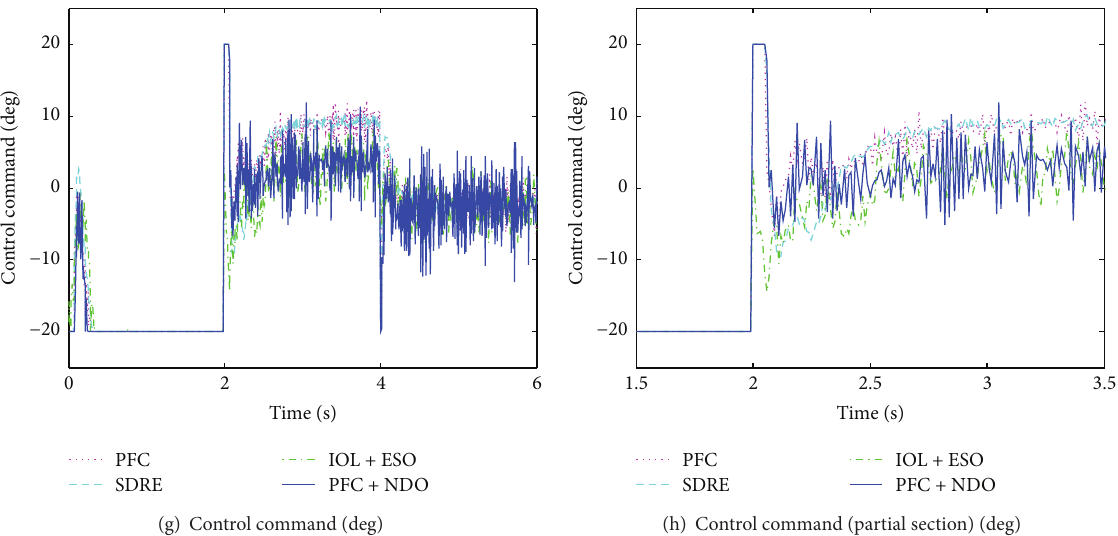
Figure 7: Simulation responses of saturation and the estimate performance of the NDO with measurement noise in the case of negative uncertainties and